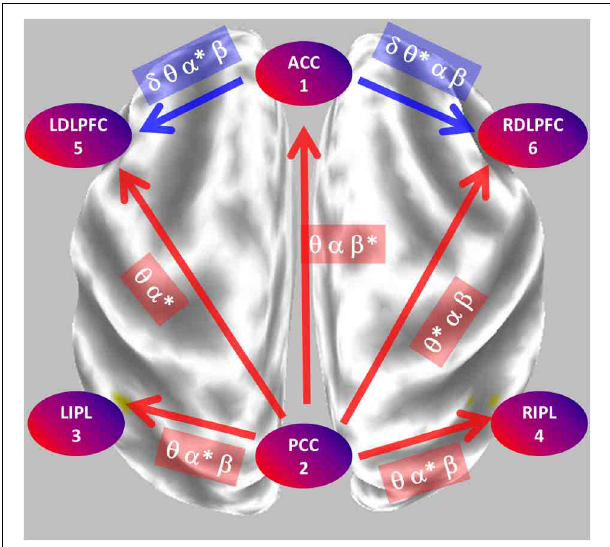
FIGURE 8 | Summary of the main statistically significant results comparing the network properties between eyes open and closed conditions. During eyes closed, the posterior cingulate significantly sends mostly alpha oscillations to all other regions. During eyes open, the anterior cingulate significantly sends mostly theta-alpha oscillations to the dorsolateral pre-frontal cortices. PCC, posterior cingulate cortex; ACC, anterior cingulate cortex; LIPL, RIPL, left and right inferior parietal lobule; LDLPFC, RDLPFC, left and right dorsolateral pre-frontal